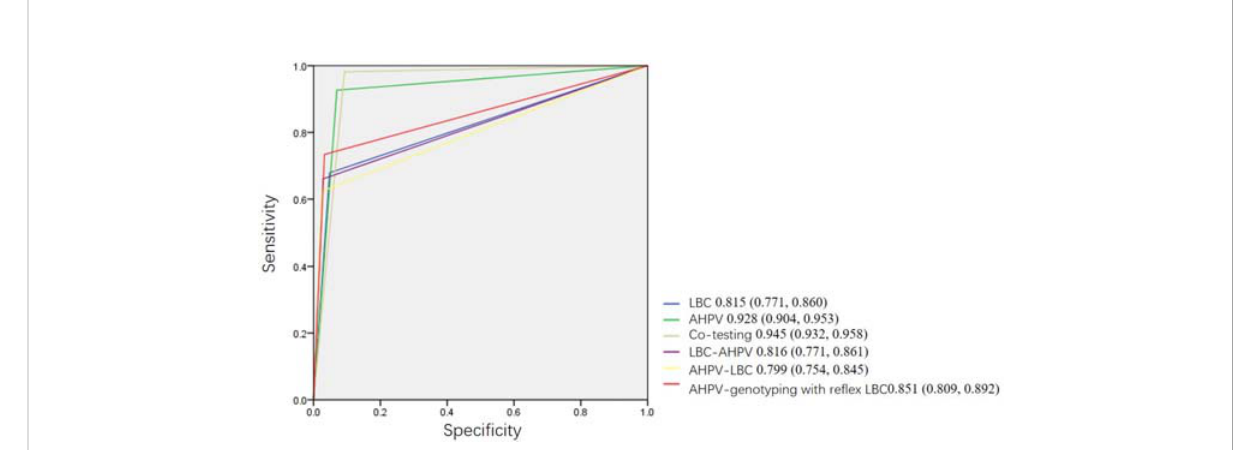
FIGURE 3 Receiver operating characteristic curves (ROC) of different primary screening tests, combined screening, and triage